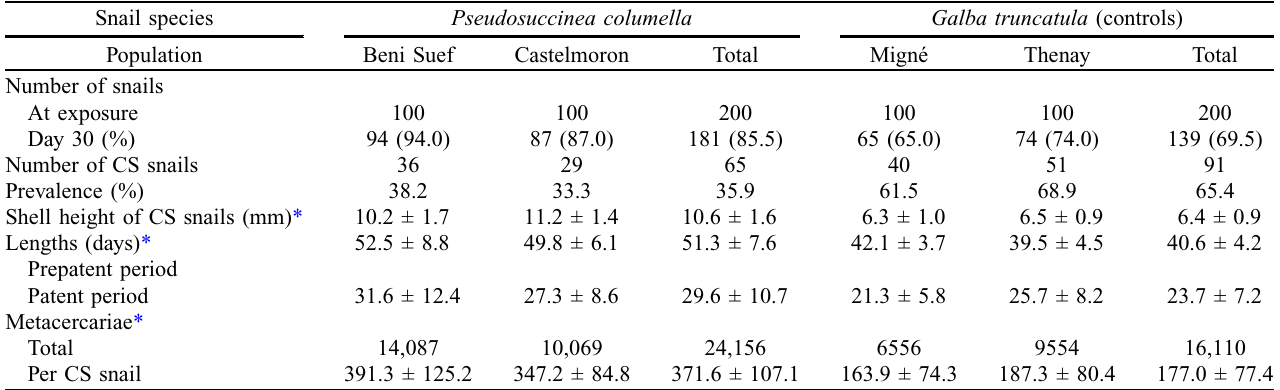
Table 1. Snail survival on day 30 post-exposure, prevalence of Fasciola hepatica infection, shell height of cercariae-shedding (CS) snails at their death, lengths of prepatent and patent periods, and number of metacercariae in four groups of pre-adults subjected to individual bimiracidial exposures and raised at 23 (cid:2)